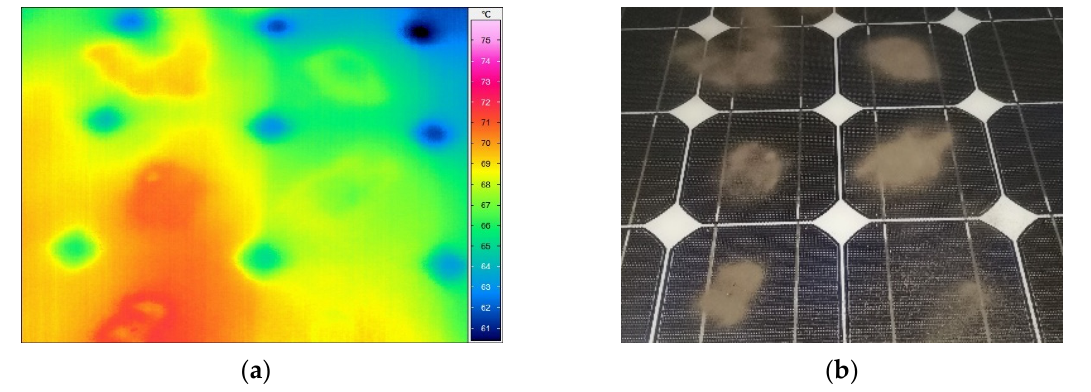
Figure 18. ( a ) Thermographic picture and ( b ) normal image of the solar panel.